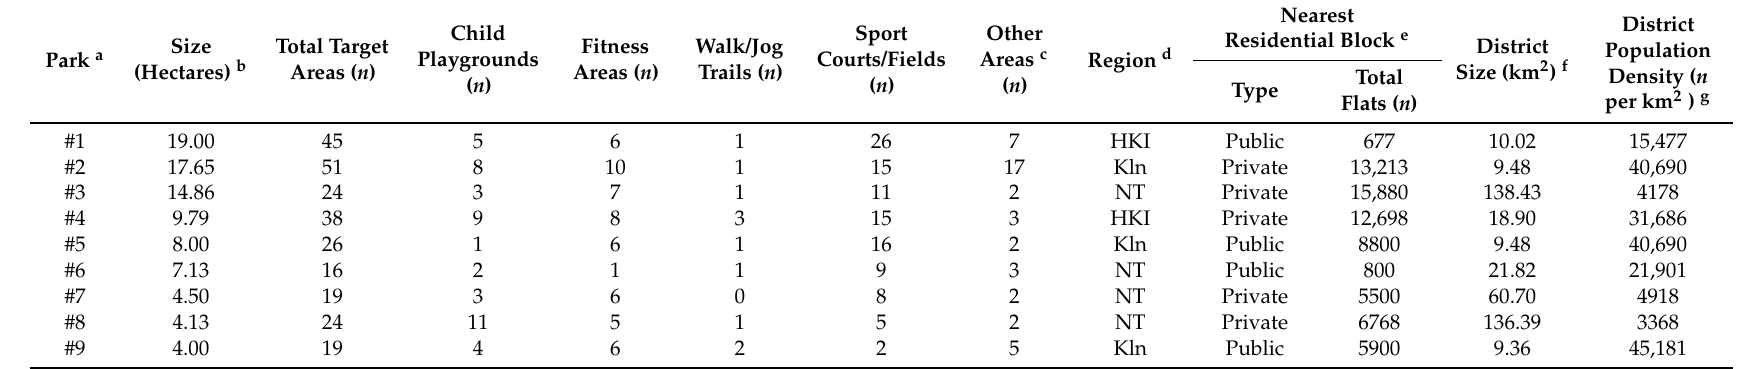
Table 1. Characteristics of the nine selected parks and their surrounding